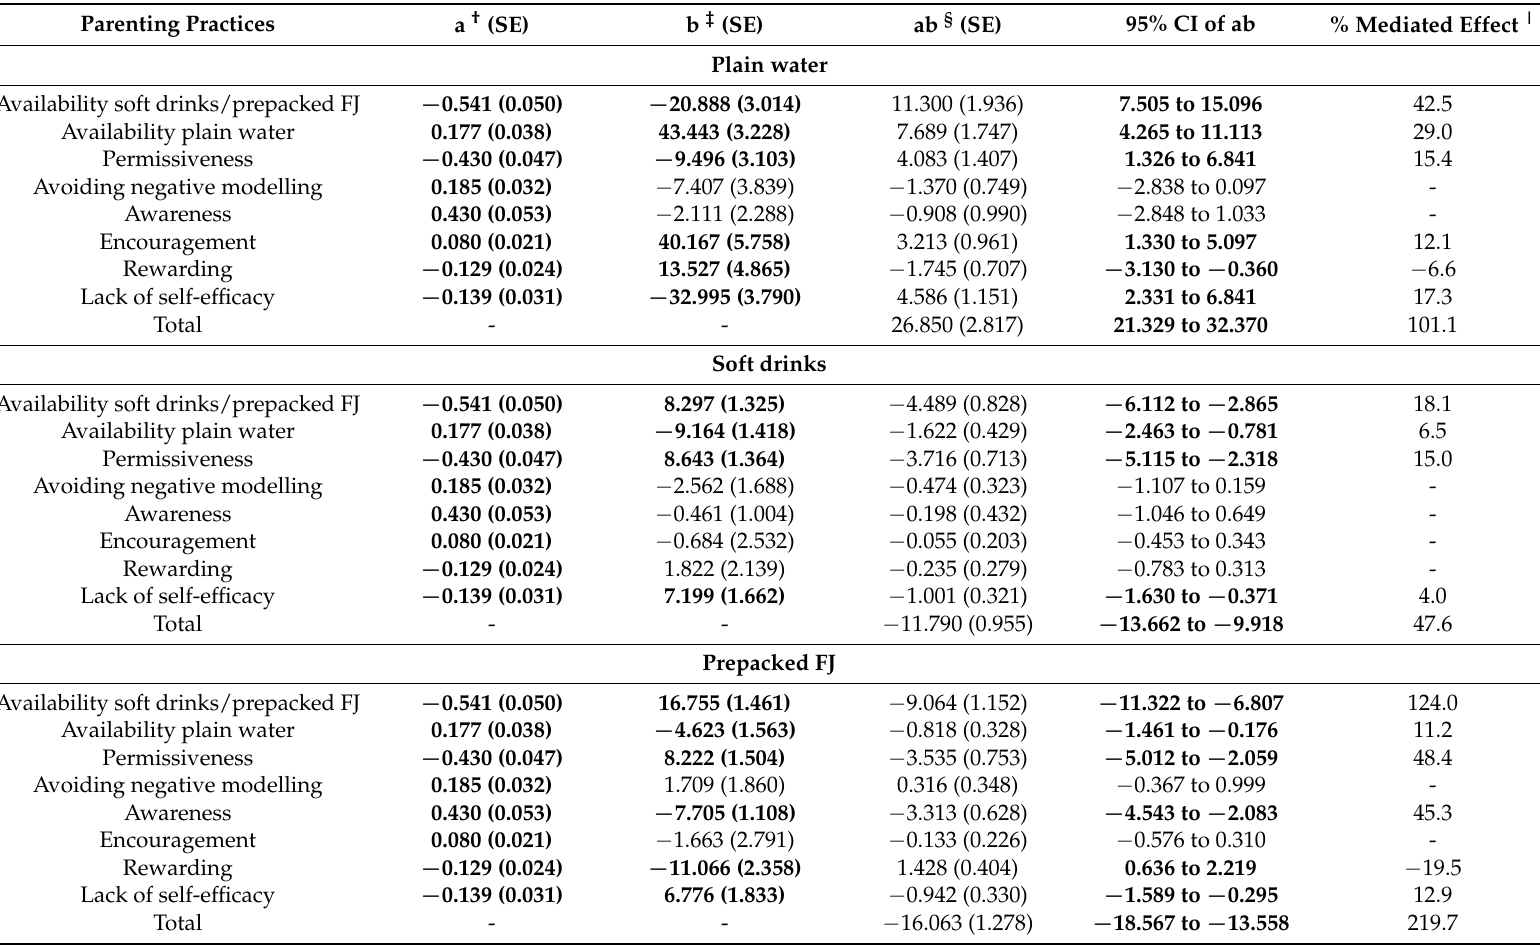
Table 3. Results from the multilevel multiple regression analyses (four level random intercept model) with plain water, soft drinks and prepacked fruit juice as the outcome variables. All analyses were adjusted for preschoolers’ age and gender (total